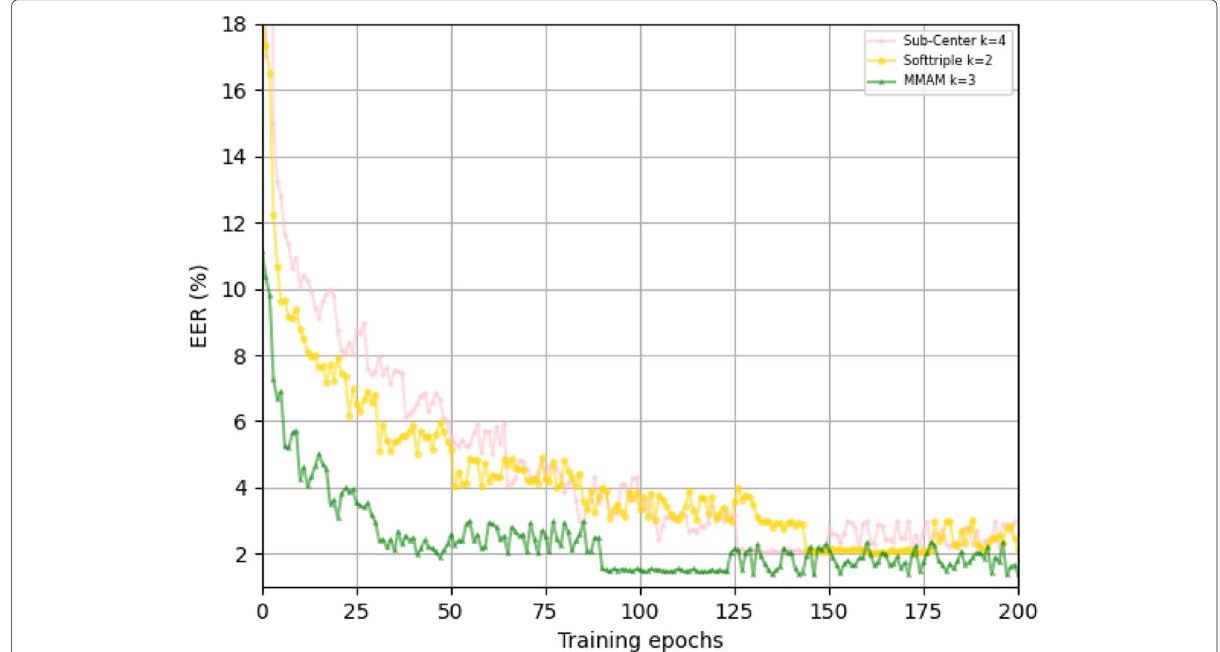
Fig. 5 MMAM converges faster with lower EER(%) values on AP17-OLR